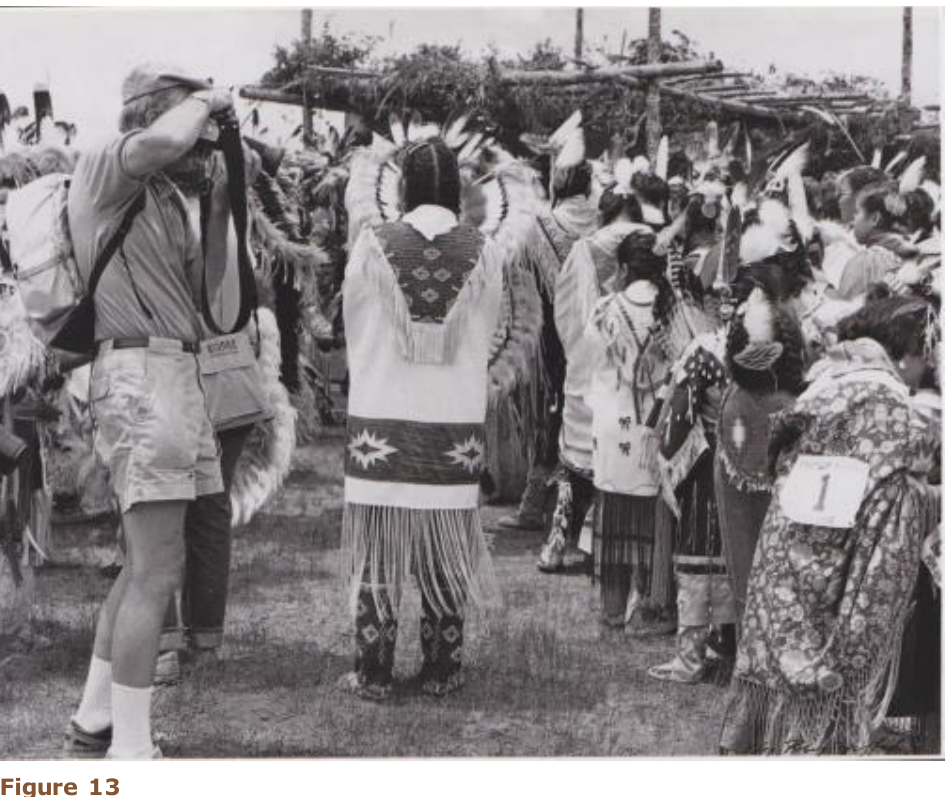
Zig Jackson, Untitled from Indian Photographing Tourist Photographing Indian series, 1991. Silver gelatin print, 16 x 20 in. Image courtesy of Zig